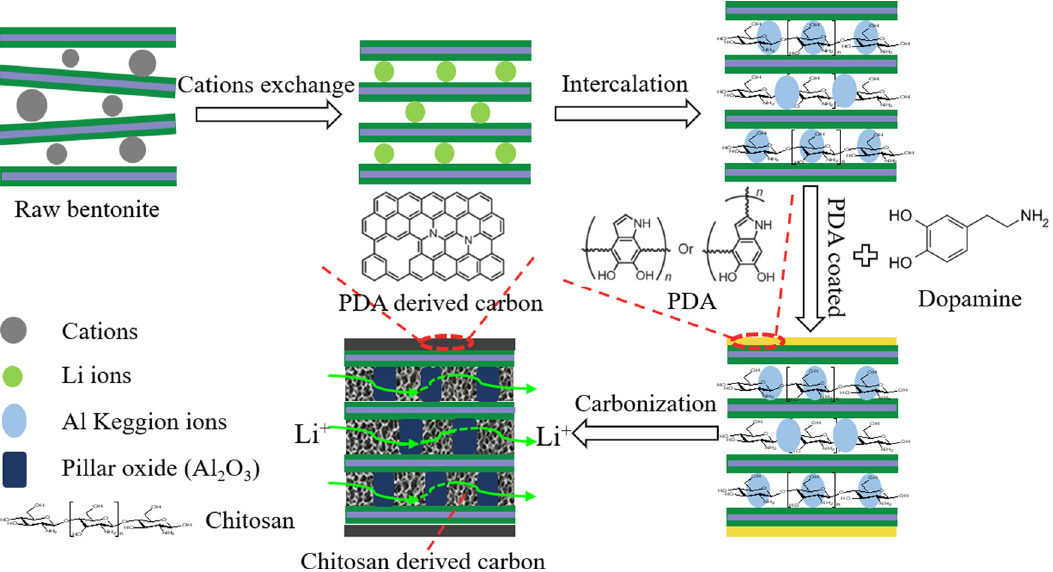
Figure 1: Schematic illustration of the synthesis of Bent@C host materials for sulfur